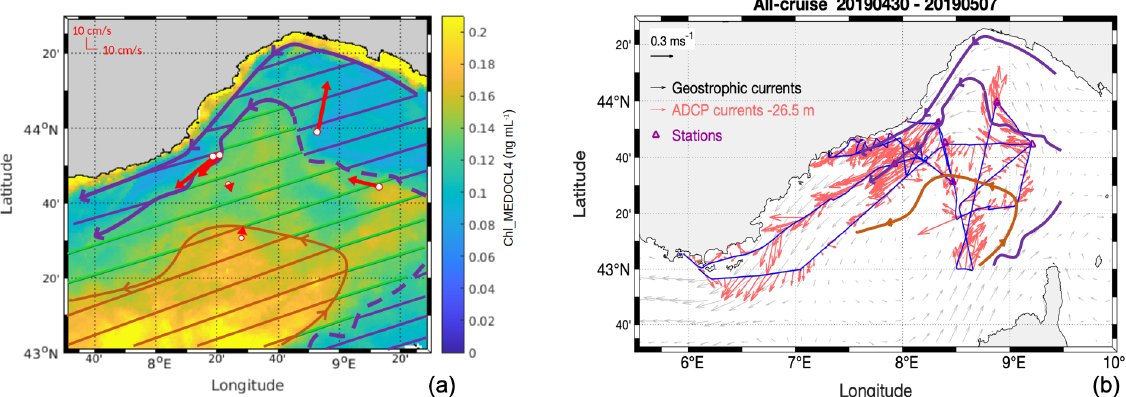
Figure 3. Panel (a) presents the satellite Chl- a averaged concentration (Chl_MEDOCL4, ngmL − 1 ) from 1 to 6 May 2019, used to set the drawn hatched boundaries between the hydrodynamic zones, superimposed with horizontal velocities (VM-ADCP, red vectors) at the stations, averaged over 25–150m. Panel (b) shows the ADCP horizontal currents at 26.5m depth superimposed on surface geostrophic currents from satellite